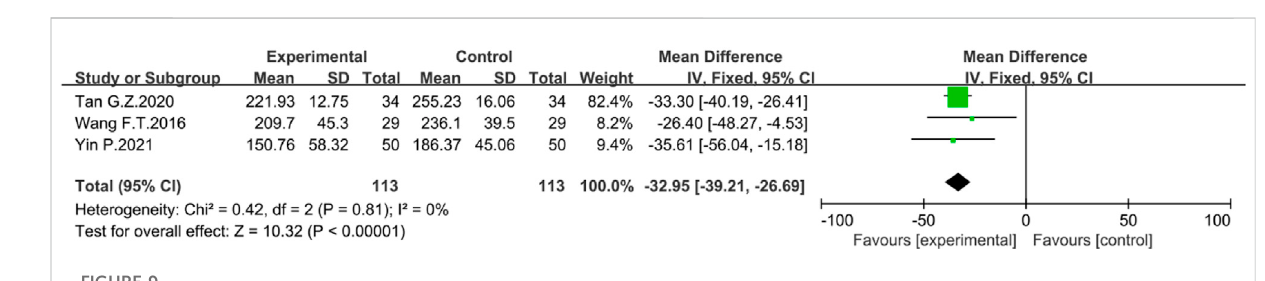
FIGURE 9 Forest plot showing the result of